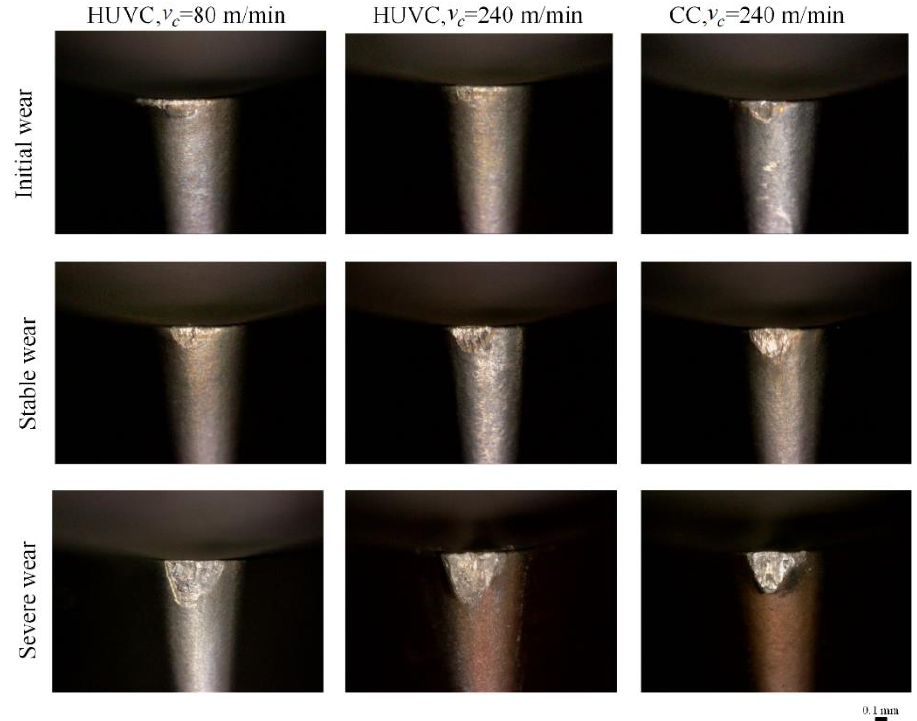
Figure 12. Flank wear at different cutting speeds at different stages of cemented carbide tools when machining Ni alloys. The cooling pressure, duty cycle, feed per revolution, and cutting depth are 10 MPa, 0.5, 0.005 mm/r, and 0.2 mm, respectively. 𝑣 𝑐 , cutting speed.